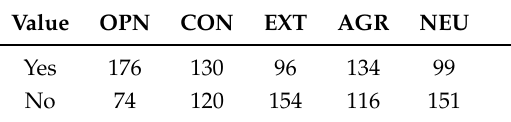
Table 2. Distributions of the myPersonality dataset.